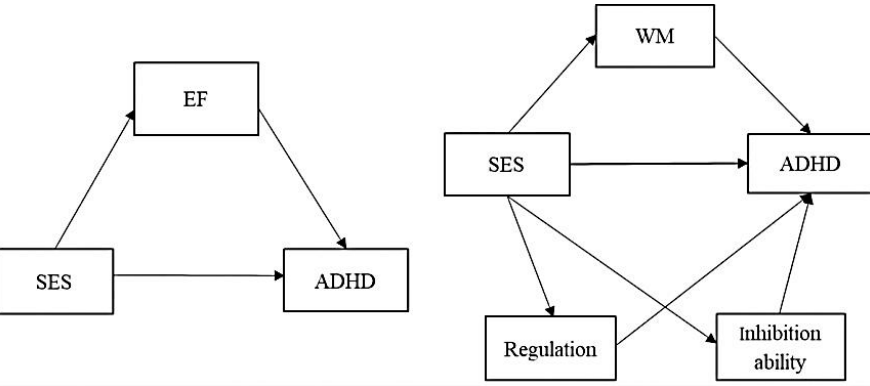
Figure 1. Model of the mediating role of preschool children’s EF and its dimensions between SES and ADHD. SES—socioeconomic status; EF—executive function; ADHD—attention deficit/hyperactivity disorder; WM—working memory. The same applies to the tables in this paper.